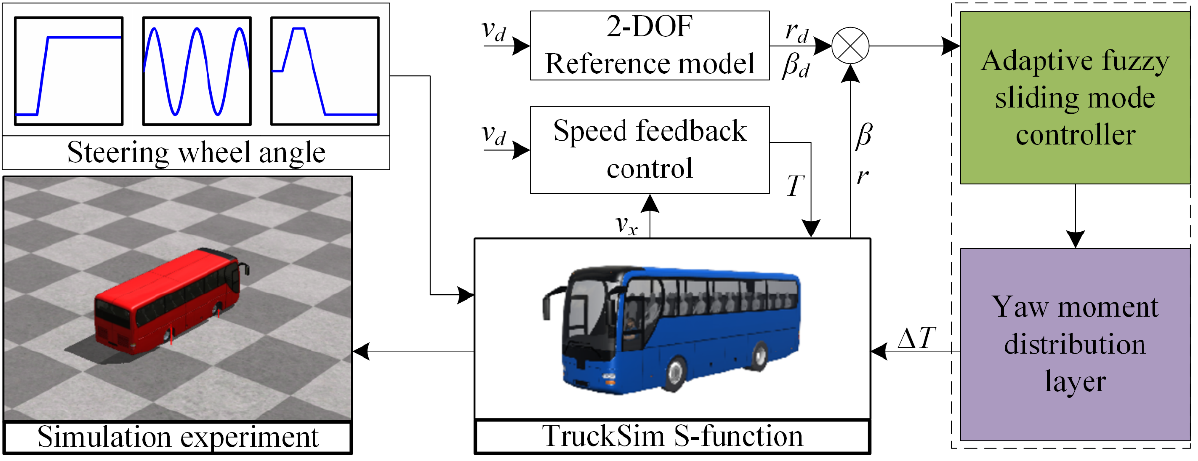
Figure 6. The block diagram of the simulation test flow.